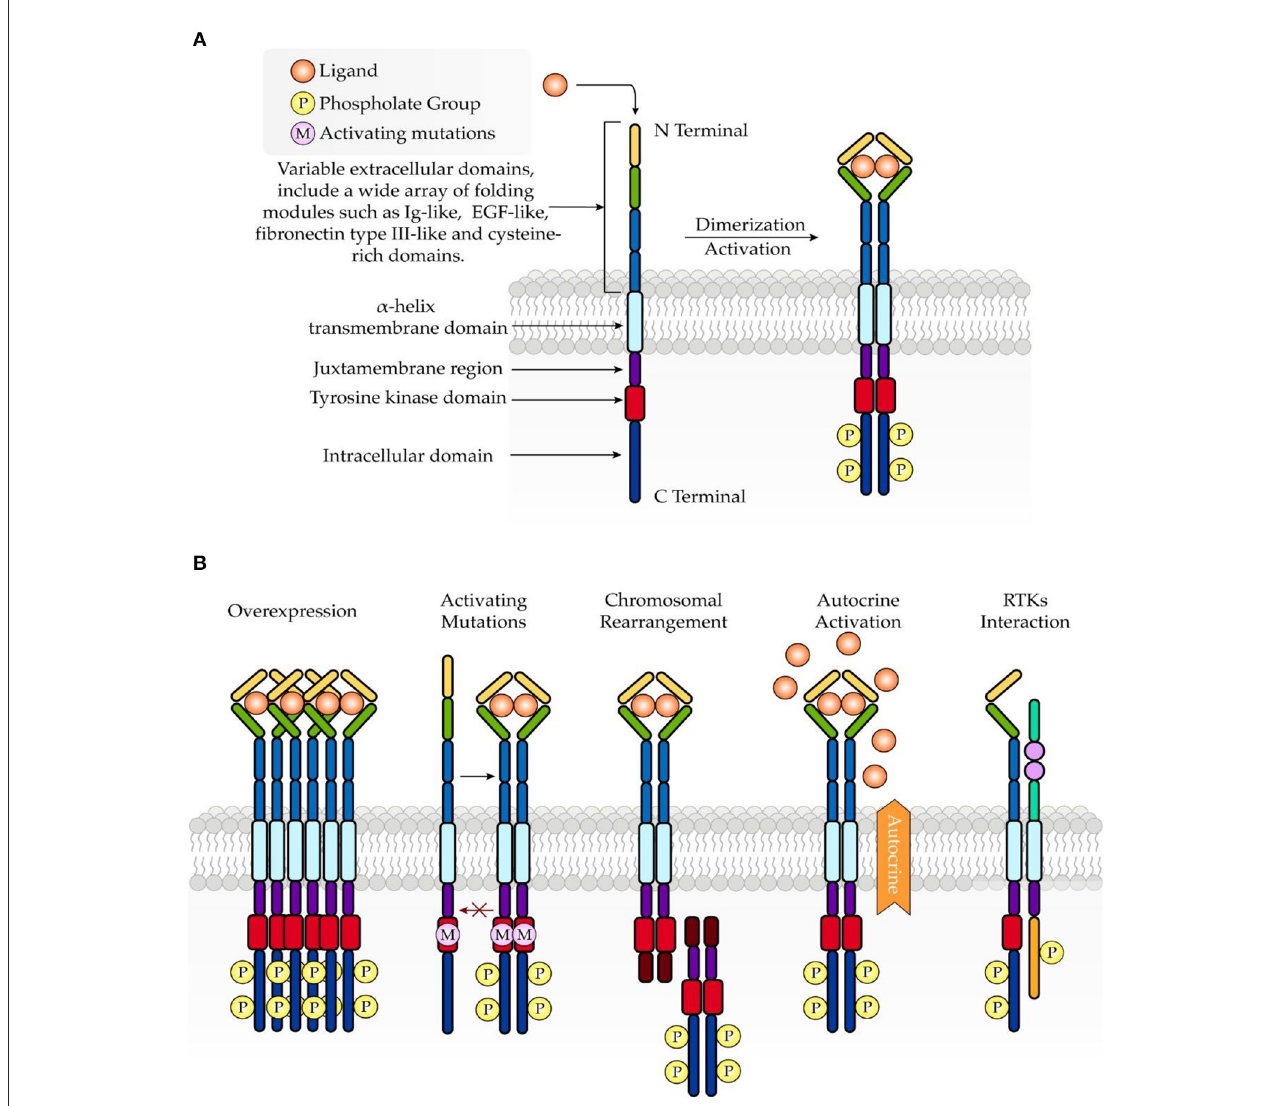
FIGURE1 Schematic structure of RTKs and common mechanisms involved in oncogenesis. (A) RTKs consist of an extracellular ligand-binding domain, a transmembrane domain, and an intracellular tyrosine kinase domain. Upon ligand binding, RTKs undergo dimerization, which further leads to activation of the intracellular tyrosine kinase domain. (B) Abnormal activation of RTKs in turmor growth is associated with overexpression, mutations, chromosomal rearrangement, autocrine activation, and RTK